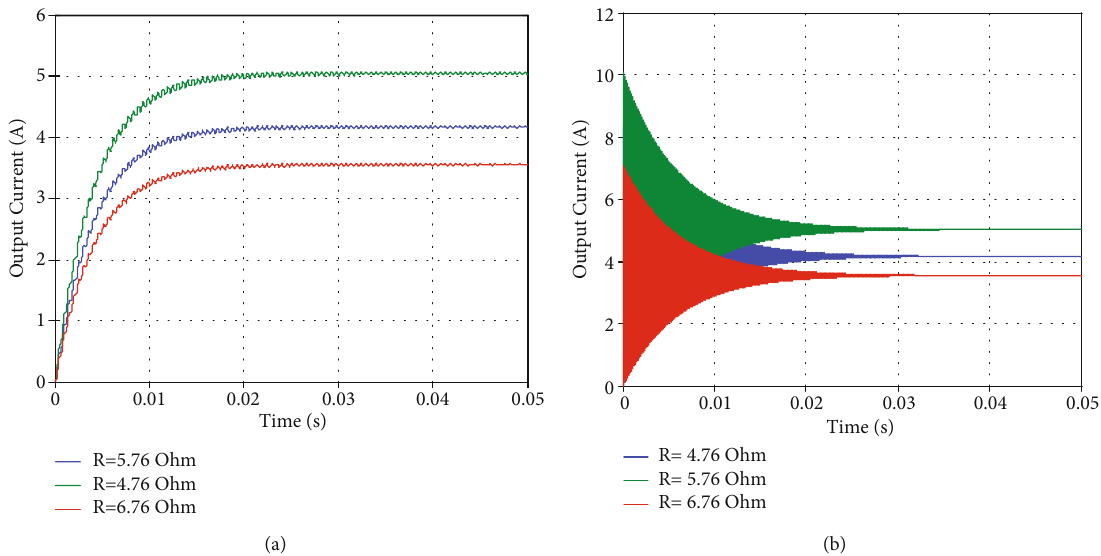
Figure 12: Simulated responses of I